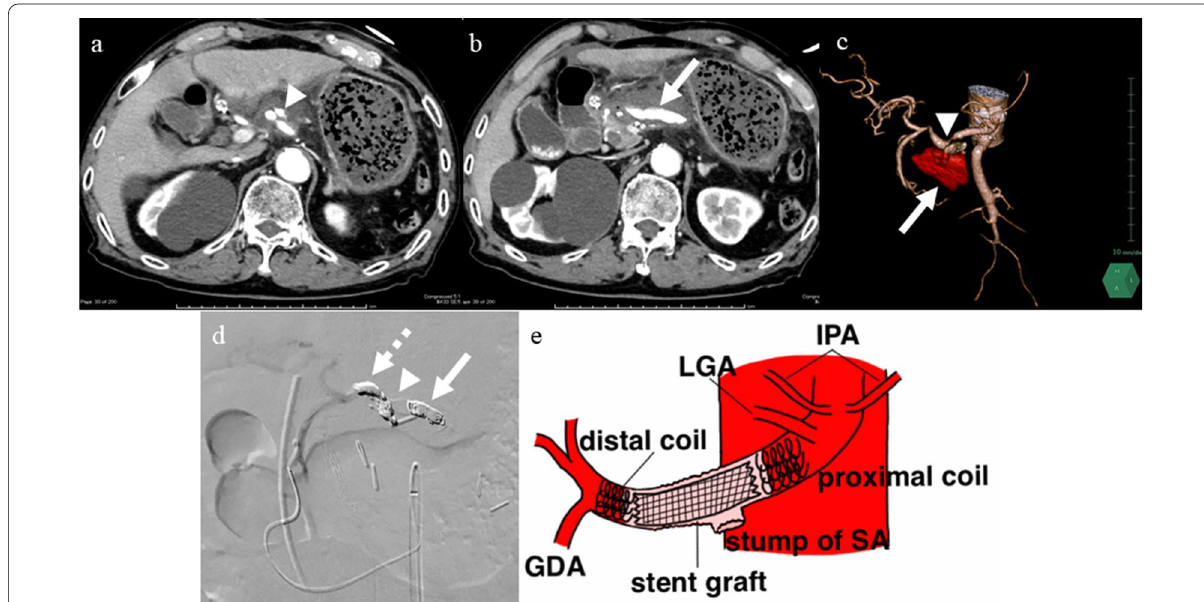
Fig. 3 Imaging findings at postoperative day 6. a Enhanced CT showed a pseudoaneurysm at the stump of the splenic artery (arrowhead). b Enhanced CT showed extravasation of contrast medium (arrow). c Reconstruction image of the abdominal arteries and extravasation from the stump of the splenic artery (arrow). Stenosis and poststenotic dilatation of the common hepatic artery (arrowhead). d Superior mesenteric artery to the gastroduodenal artery angiography after placement of the stent graft (arrowhead), proximal coil (arrow), and distal coil (dotted arrow). e Schema after the placement of stent graft and coil embolization. GDA gastroduodenal artery, LGA left gastric artery, IPA infraphrenic artery, SA splenic